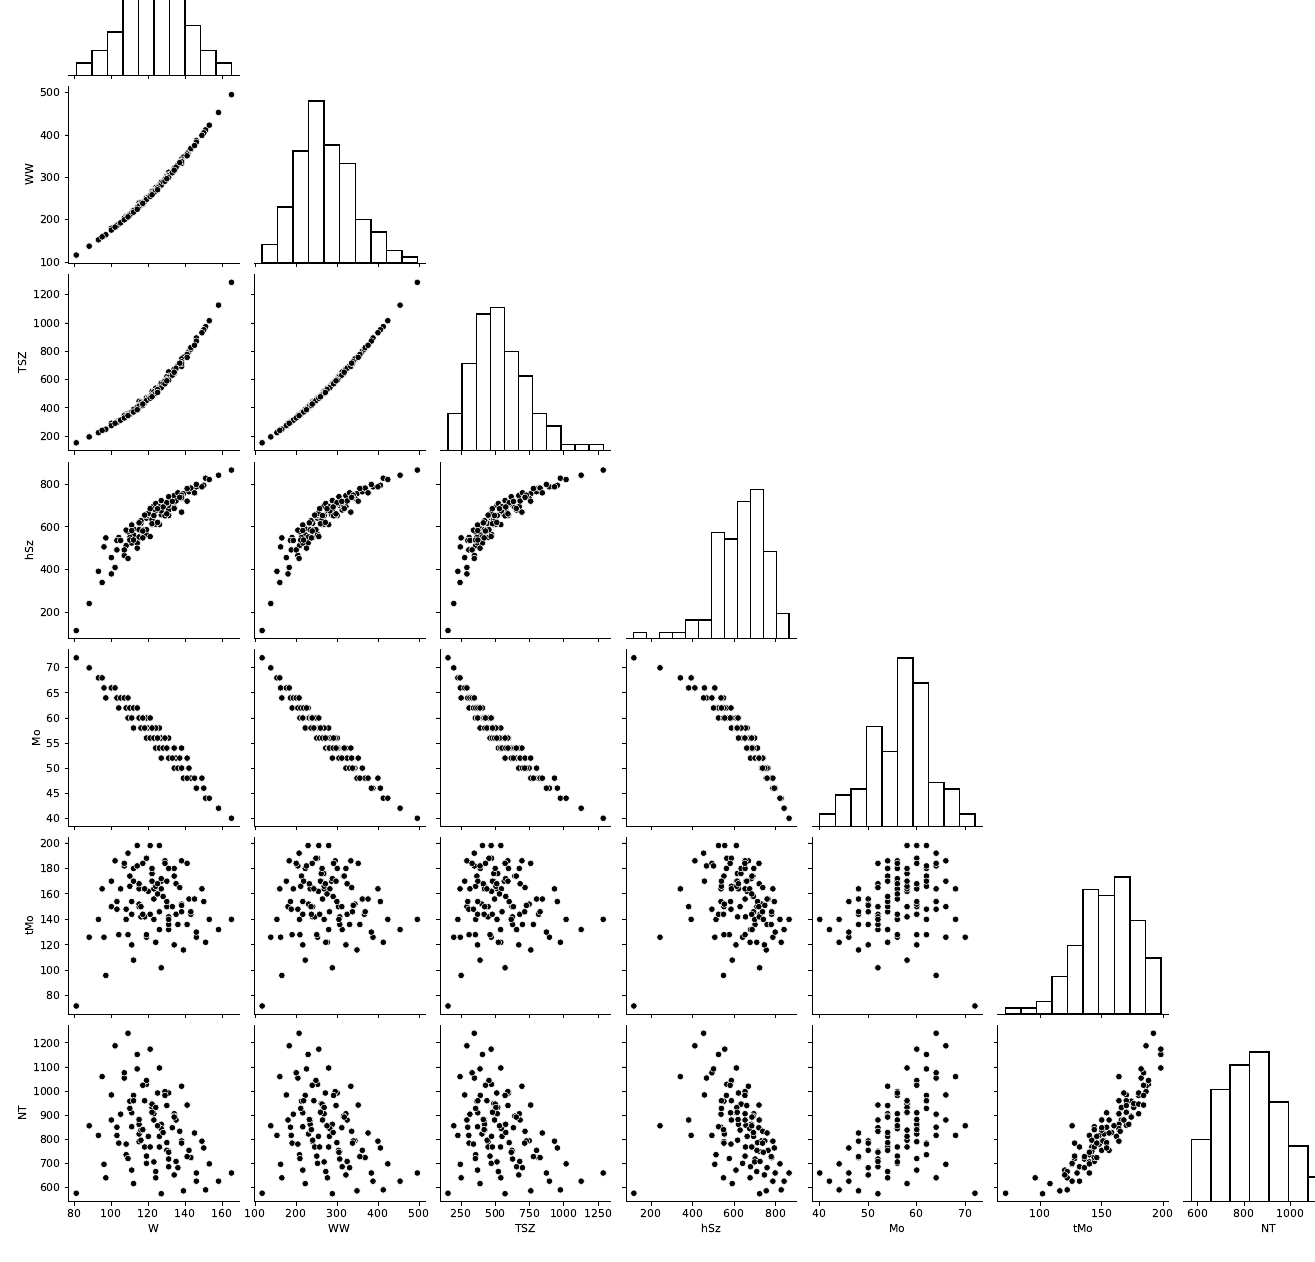
Figure 1: Correlations among Trinajsti´c, Wiener, hyper-Wiener, Tratch-Stankevich-Zefirov, hyper-Szeged index, Mostar, and total-Mostar